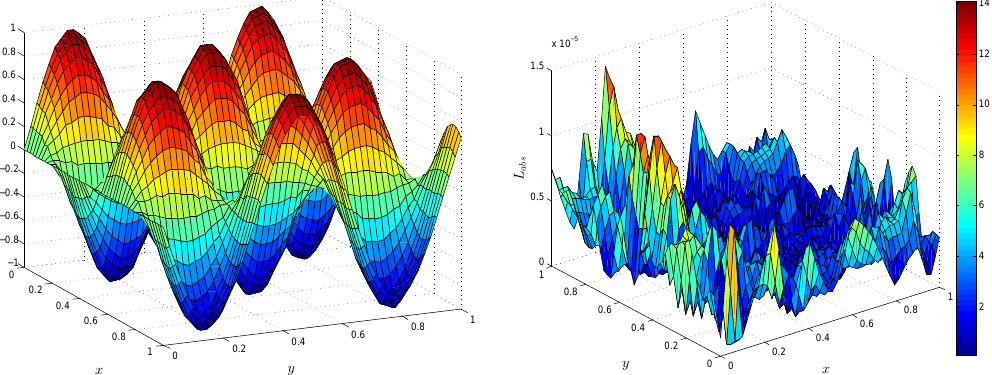
Figure 9. Numerical approximation ( left ) and L abs error norm ( right ) for Problem 3 for N = 400.